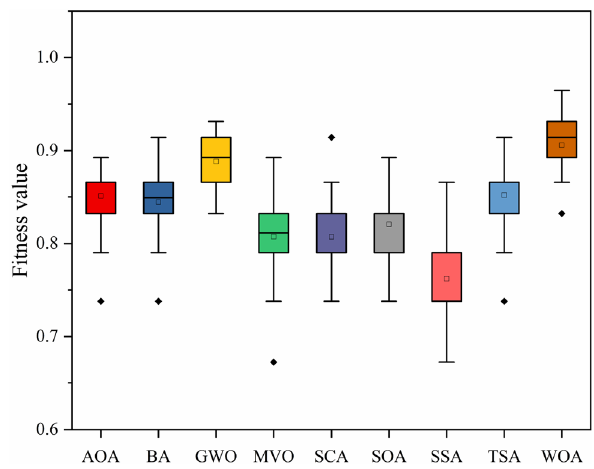
Fig. 11 The ANOVA tests of the algorithms for case 1